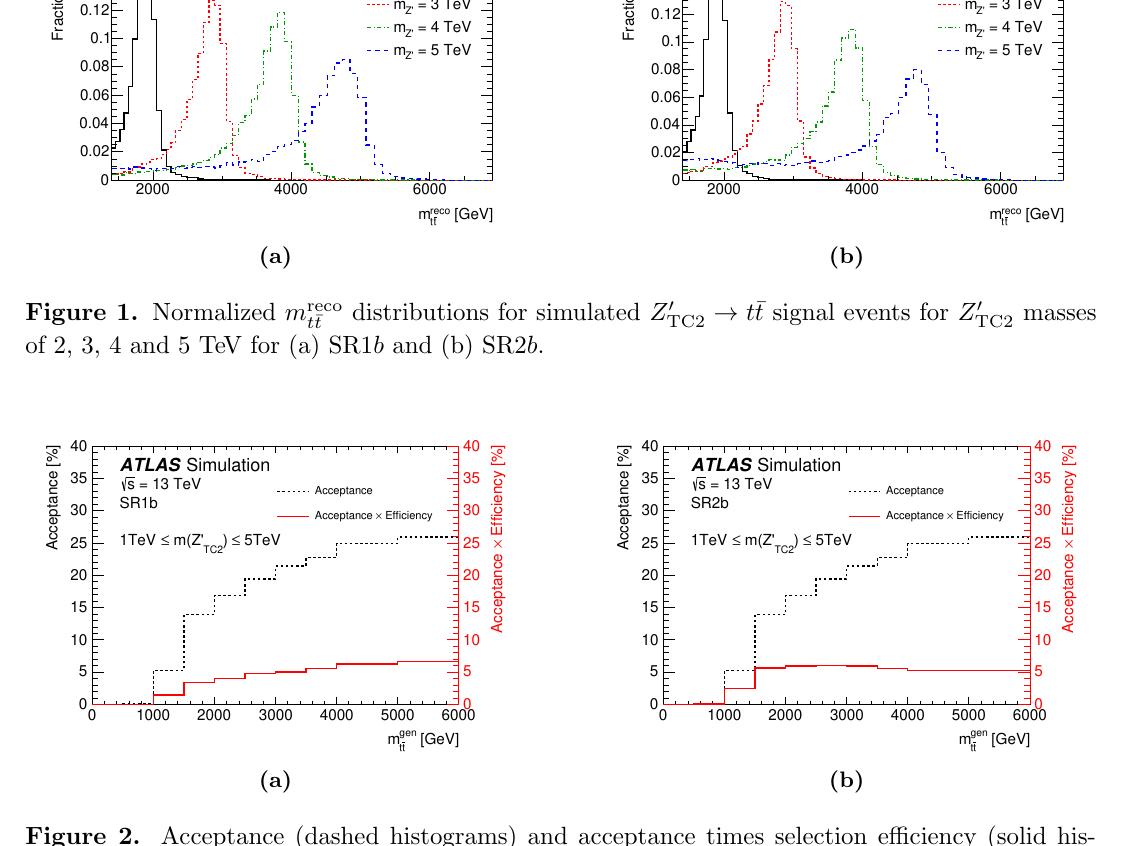
Figure 2. Acceptance (dashed histograms) and acceptance times selection e(cid:14)ciency (solid his- tograms) as a function of m gen t (cid:22)